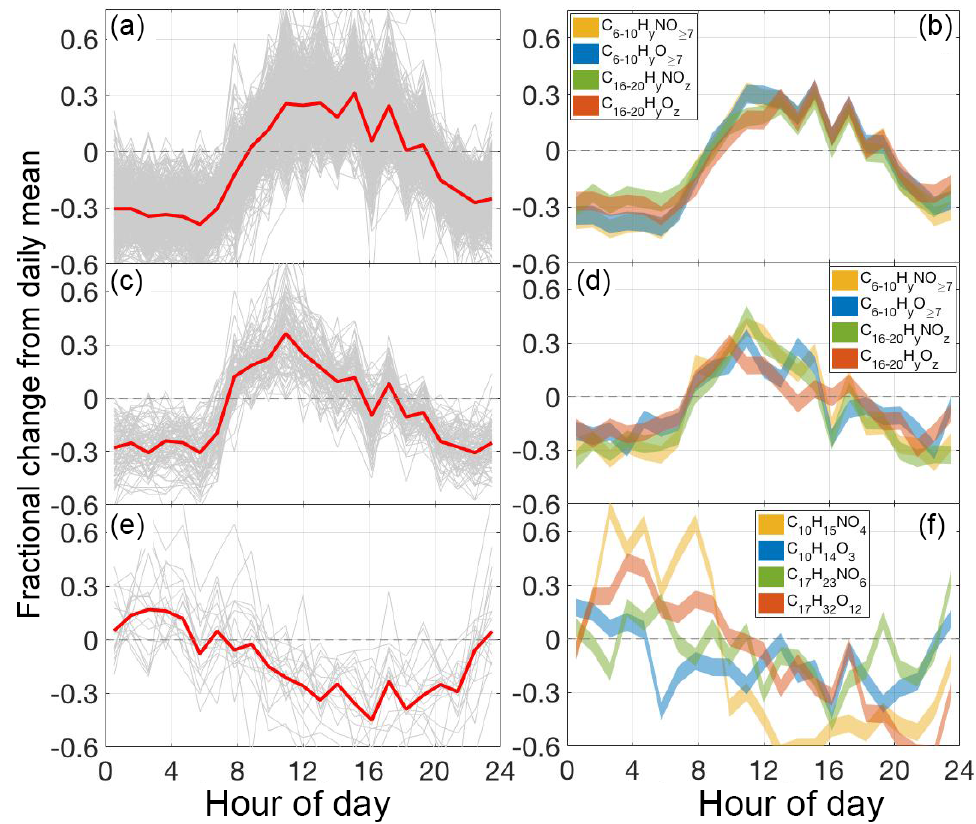
Figure 4. Fractional change from the daily mean of the organic gas-phase species belonging to the (a) daytime, (c) morning, and (e) night- time subgroups, as categorized using non-negative matrix factorization. Red lines in (a) , (c) , and (e) represent the means of the species in that subgroup. (b) , (d) , and (f) show diel trends of all qualifying gON and gOC HOM monomers and dimers corresponding to the three subgroups shown in (a) , (c) , and (e) , respectively. Individual species, as opposed to the mean of a collection of compounds, are shown for the (f) nighttime subgroup, as only 20 species exhibited a nighttime diel